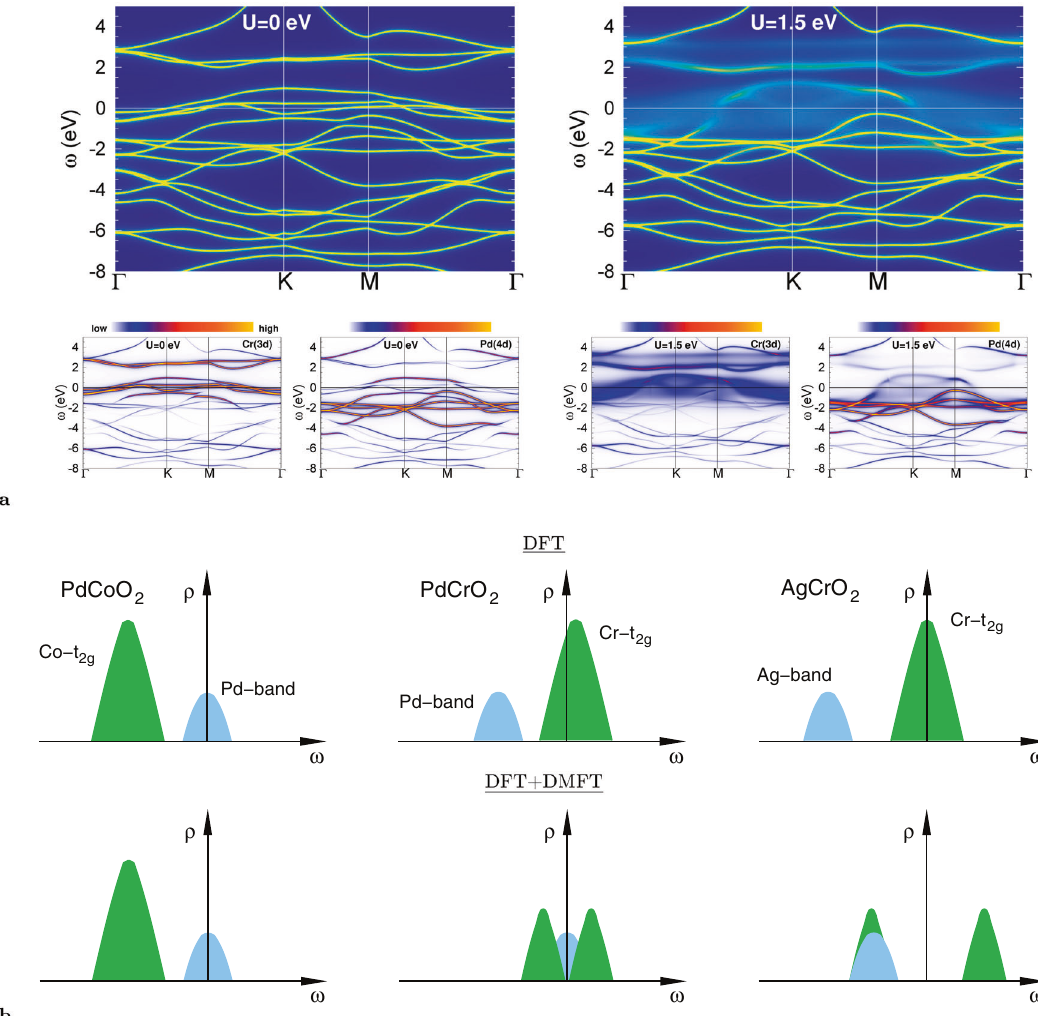
Fig. 6 On the correlation features in delafossites. a Spectral properties of PdCrO 2 for different interaction strengths. Left panel: U = 0 eV, i.e., DFT bands. Right panel: U = 1.5 eV. Top: spectral function, bottom: fatbands for Cr(3 d ) (left) and Pd(4 d ) (right) (from 72 ). b Sketch of the basic differences in the k -integrated spectral function ρ ( ω ) for the most-relevant four bands close to the Fermi level among the studied delafossites. Top: DFT, bottom: DFT + DMFT. Left: PdCoO 2 : Co- t 2 g bands occupied, uppermost Pd(4 d )-band half fi lled; middle: hidden-Mott PdCrO 2 : Cr- t 2 g bands 1/3 fi lled, uppermost Pd(4 d )-band occupied; right: band-Mott insulating AgCrO 2 : Cr- t 2 g bands half fi lled, uppermost Ag(4 d )-band to what is shown in Fig. 3d, rendering the mechanism for the transition clear: The three bands at the Fermi level are fi lled with two electrons, and hence four electrons populate the altogether four bands when counting down in energy from ε . These four F bands are of mixed Cr(3 d ), Pd(4 d ) character, with dominance from the 3 d sector. Due to the given band entanglement, strong correlations transform three of them into Hubbard bands, and leave a resulting one with half fi lling at the Fermi level. Interestingly, for the intermediate coupling (right panel of Fig. 6a), the system adopts a ’ strange ’ situation. The Cr- t 2 g dispersions are very incoherent and not yet Mott localized, and the cPd dispersion is not yet fully established coherently. Note that especially the cPd dispersion, which appears weakly- interacting at strong and weak coupling, is intriguingly affected by correlations close to the given metal-to-metal transition. This underlines the intricate inter-layer physics that is at work in PdCrO 2 with its ’ hidden-Mott ’ state. Note that in a pure model context, at least three bands would be necessary to capture a hidden-Mott scenario: one fully fi lled band and two bands with